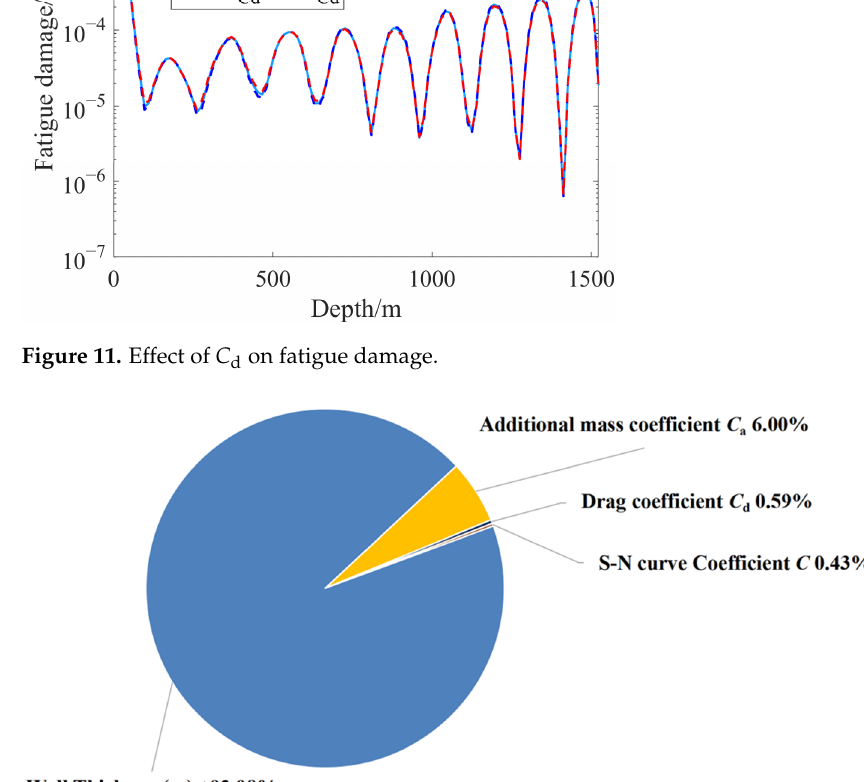
Figure 12. Parameter sensitivity analysis of fatigue damage.